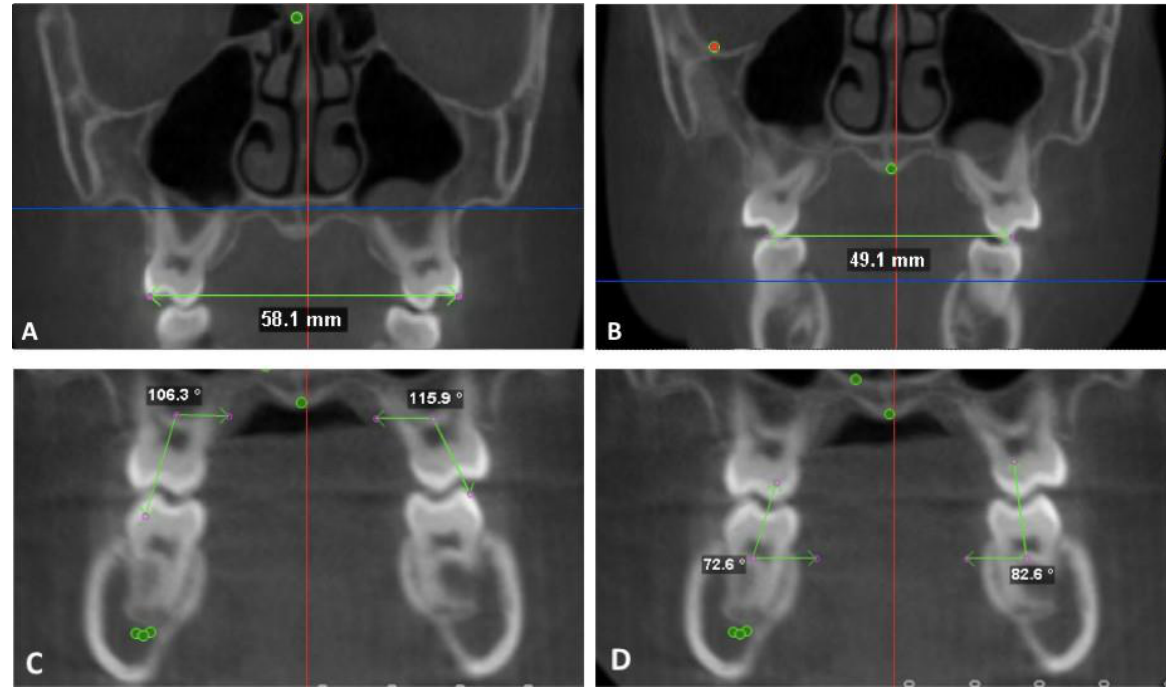
Figure 4. Dental measurements. Intermolar width and inclination with the maxillary and mandibular first molars. ( A ) maxillary intermolar width at the buccal cusp tips. ( B ) mandibular intermolar width at the buccal cusp tips. ( C ) maxillary molar buccolingual inclination ( D ) mandibular molar buccolingual inclination.